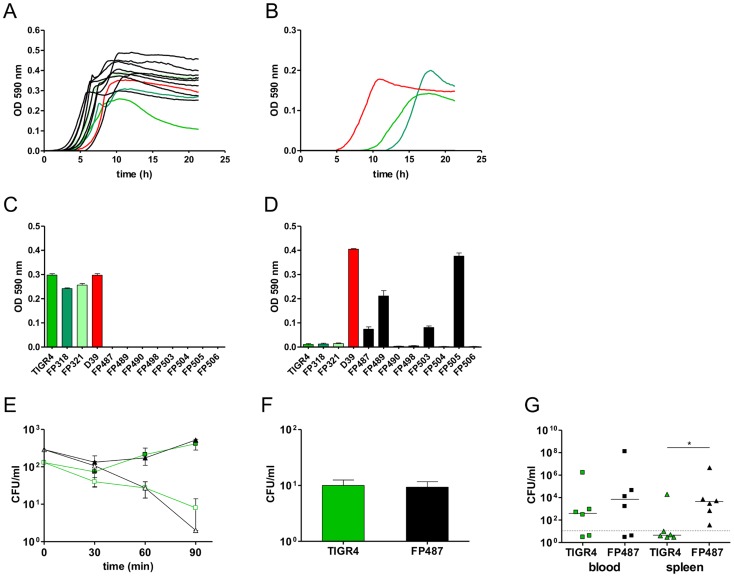
Phenotypes of single-colony blood culture isolates.Growth profiles of wild type strains (coloured lines) and ATPase mutants (black lines) in standard laboratory media THY (A) and TSB (B). D39 is indicated in red while TIGR4, FP318 and FP321 in different shade of green. (C, D) Maximum OD590 reached by wild type and ATPase mutants during growth with 80 mM K2HPO4 and pH 8.0 (D) and growth at pH 6.6 (E). Kinetics of opsono-phagocytosis assays in rotating blood with anti-type 4 serum (open symbols) and without antibodies (filled symbols) of parental strains (green) compared to a SP1507 atpC mutant (black). (F) Phagocytosis with primary cultures of spleen macrophages of TIGR4 and FP487 atpC mutant. (G) Bacterial counts in blood (squares) and spleen (triangles) at 72 h after i.v. infection of BALB/c mice (n = 6) with TIGR4 (green) and FP487 carrying a frame shifted SP1507 atpC gene (black). Data points below the cut off are negative. All data were analyzed by Student's t-test (P<0.05).